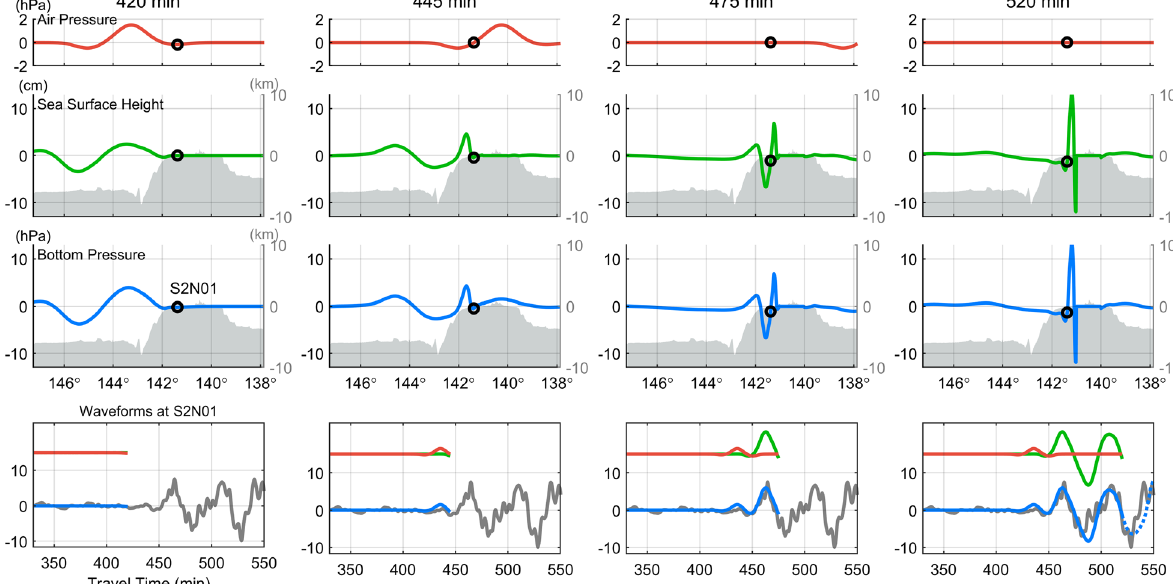
Fig. 5 The top three rows exhibit the simulated wave profiles of the air pressure wave, sea surface height, and bottom pressure in different snapshots. The gray shaded areas indicate the bathymetry profiles with height marked by the y ‑axis on the right. The bottom row displays the waveforms at S2N01. Dark lines in the bottom plots represent the observed waveform, and the red, green, and blue lines indicate the air pressure, sea surface height, and bottom pressure,